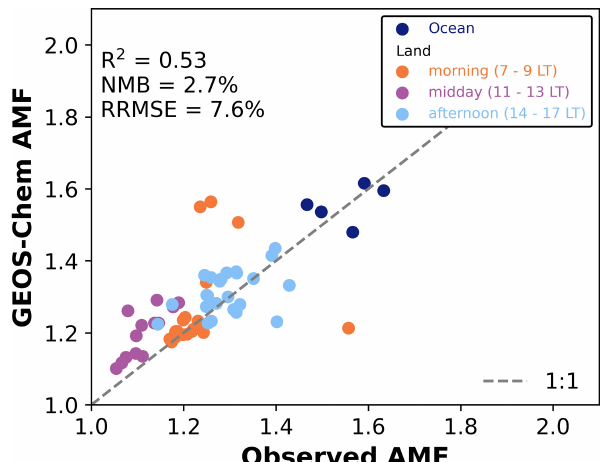
Figure 6. Variability of the air mass factor (AMF) for tropo- spheric NO 2 VCD retrievals from satellites as seen in 63 individual KORUS-AQ vertical profiles. The figure compares GEOS-Chem and the observed AMF calculated from Eq. (3). The coefficient of determination ( R 2 ), normalized mean bias (NMB), and relative root-mean-square error (RRMSE) are given in the inset. The 1 : 1 line is shown